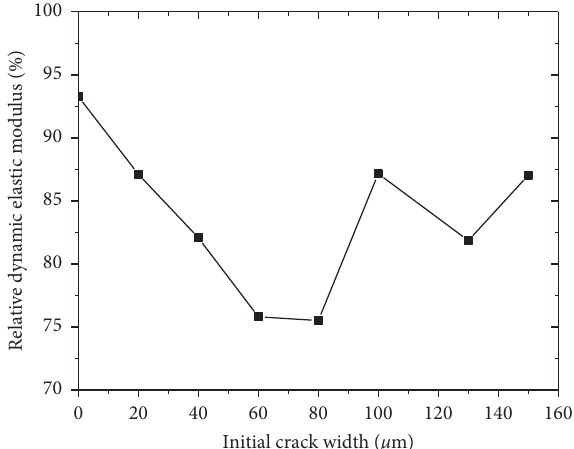
Figure 10: Changes in the relative dynamic elastic modulus of concrete after 28 salt-freezing cycles.